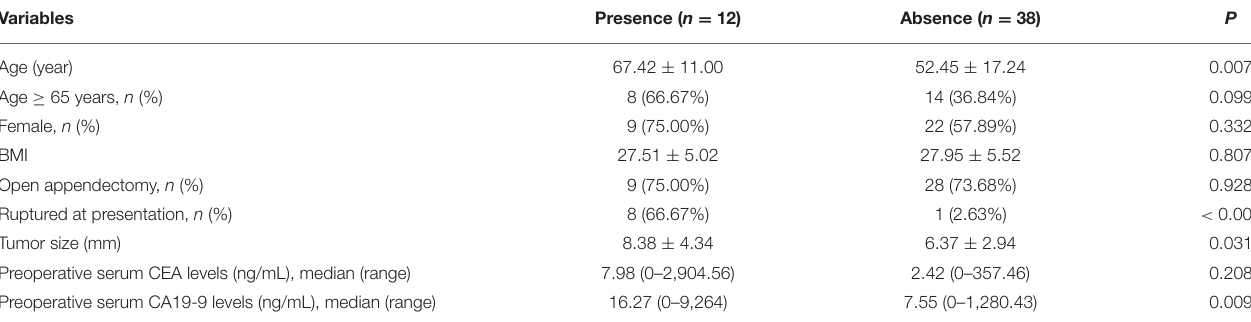
TABLE 2 | Demographics, surgical management, tumor characteristics of patients stratified by the presence and absence of PMP.